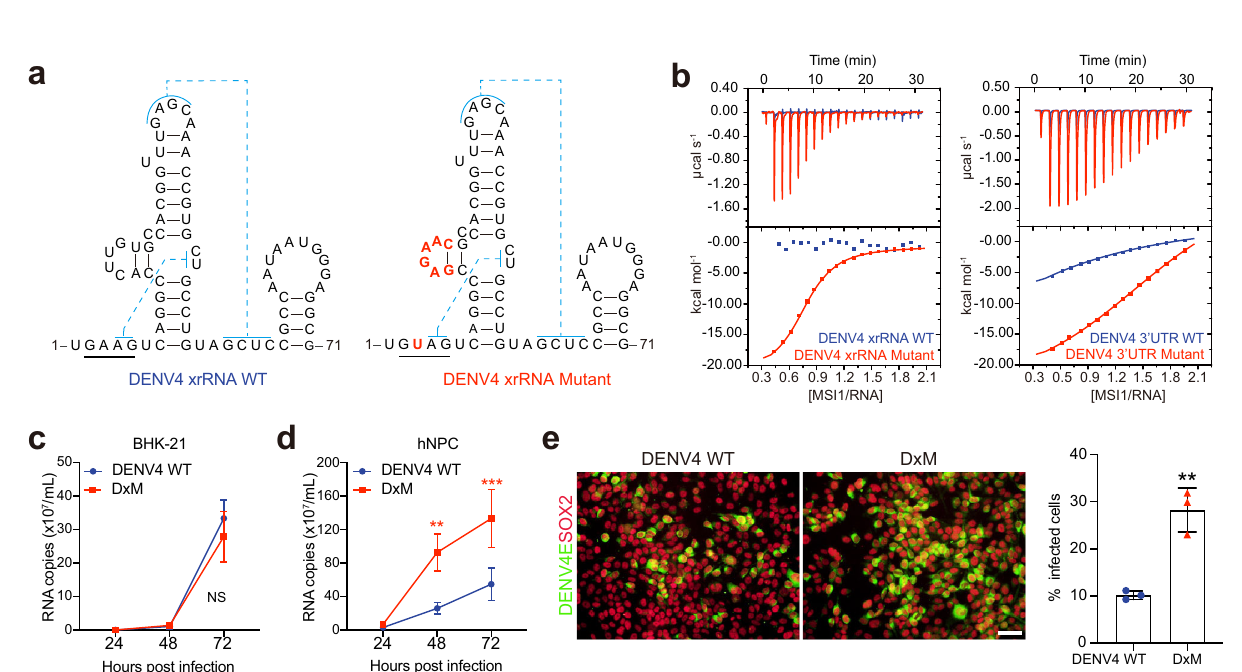
Fig.5|ThetwoMBSsofxrRNA2areuniqueamongMBFV.a Secondarystructure diagram of fl aviviral xrRNA with the pMBS1 colored in pink, the P2 loop colored in blue and the P2 stem colored in cyan. b A maximum likelihood tree constructed with the xrRNA sequences of fl aviviruses using MEGA. The pMBS1 and P2 loop sequences(coloredasin( a ))ofxrRNAsareshownafterthevirusnames.ThepMBS1 and P2 loop sequences of ZIKV xrRNA2 are framed with red rectangles. The pMBS1 sequences of the xrRNA1s of KOKV, USUV, and MVEV, which match AUAG are framed with green rectangles. The GenBank ID information of sequences used forthis analysis werelisted inTableS4. c ITC pro fi les ofRRM12to JEV/YFV/DENV2/